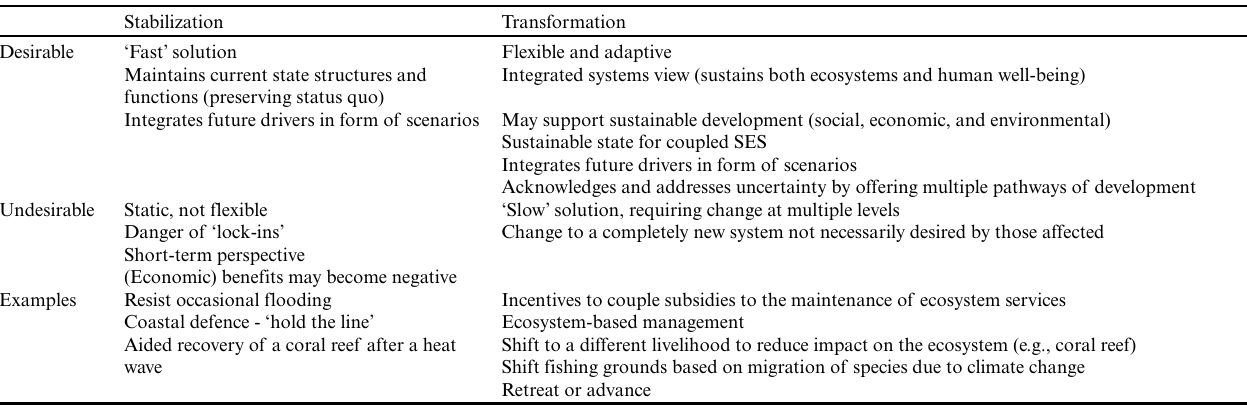
Table 1 . Desirable and undesirable characteristics in coastal social-ecological systems with regard to stabilization and transformation, and examples (Oppenheimer and Glavovic 2017, Mcleod et al. 2019, Masselink and Lazarus 2019, Bonnett and Birchall 2020, Dornelles et al. 2020, Thonicke et al.